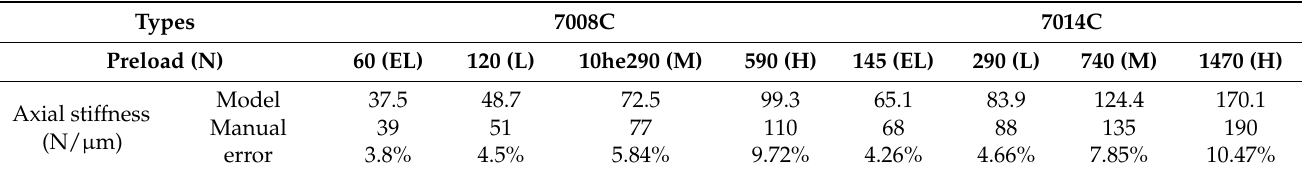
Table 2. The comparison of bearing static stiffness (NSK B7008C, B7014C) with the experimental values in bearing user manual (EL: extremely light; L: light; M: medium; H: heavy). Types